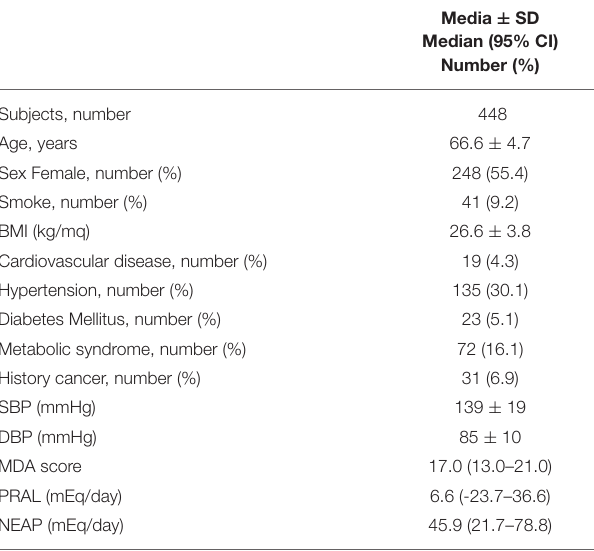
TABLE 1 | Characteristics of the study